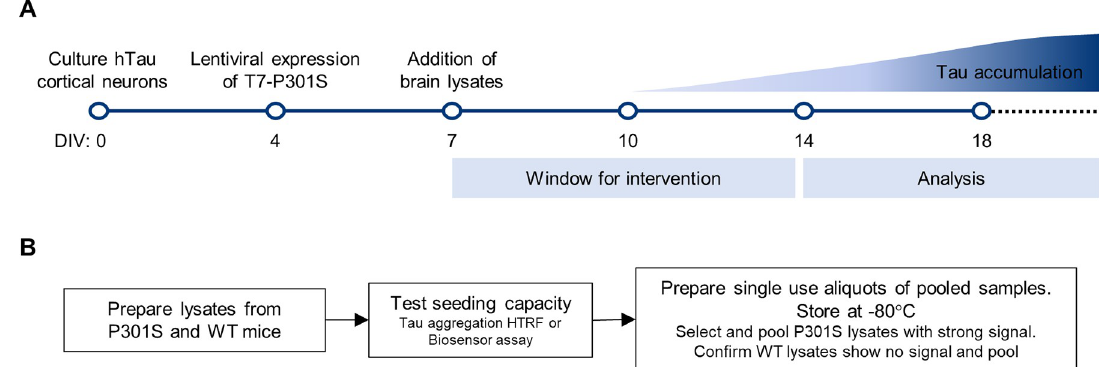
Fig 7. Implementation of the tau seeding model for drug screening. A) Diagram highlighting the key steps in the culture and treatment of primary neurons for use with the tau seeding model. Cortical neurons are cultured from hTau embryos, transduced with T7-P301S LV at DIV4 and treated with P301S lysates at DIV7. WT lysates are used as a negative control. Tau inclusions are detectable from DIV14 onwards. Treatments aimed at reducing the level of accumulated tau can be started from DIV7. The specific time-points of intervention and analysis may be defined by the end user according to experimental needs. B) Strategy for obtaining large quantities of comparable seeding material to reduce seeding variability.